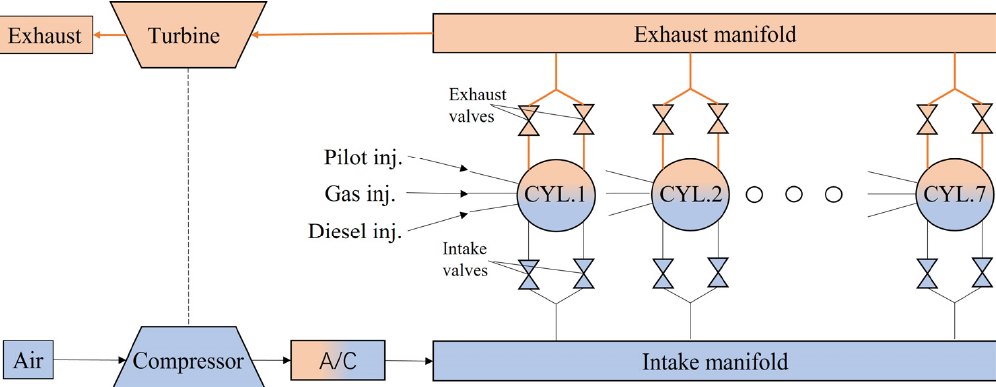
Figure 1. Structure and working principle of dual-fuel main engine.